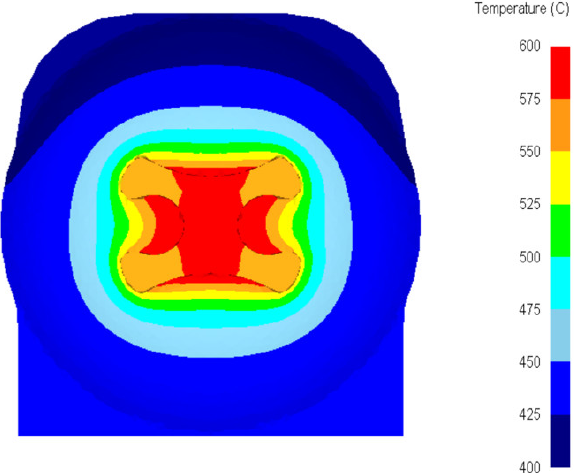
Figure 9. Temperature distribution in product along cross-section.